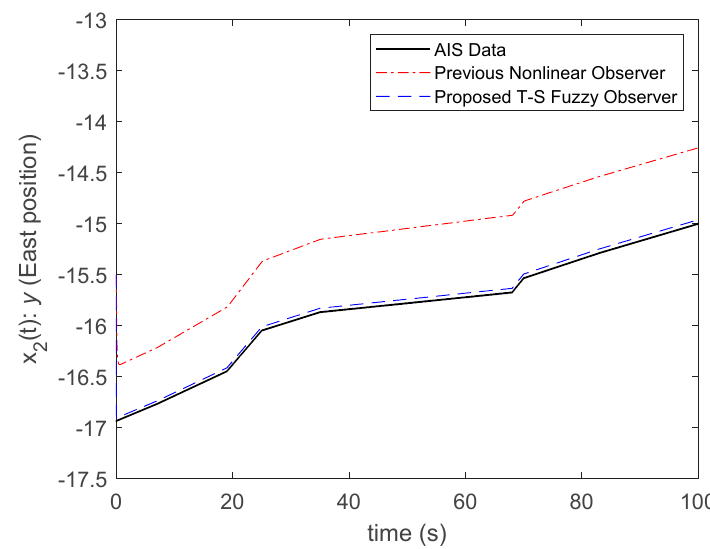
Figure 5. Comparison results of state x 1 ( t ) with [26].